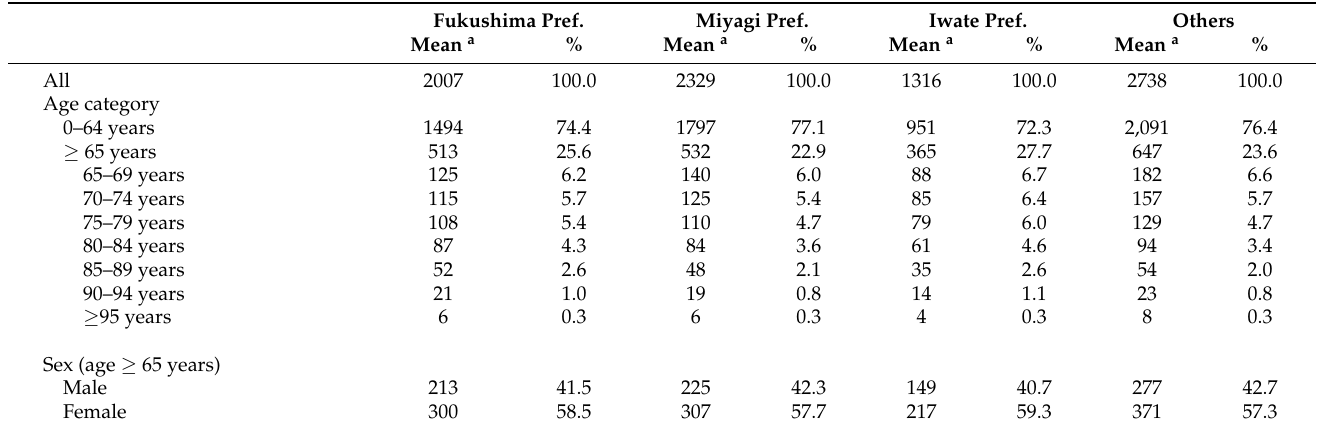
Table A1. Characteristics of the population data from 2006 to 2015.